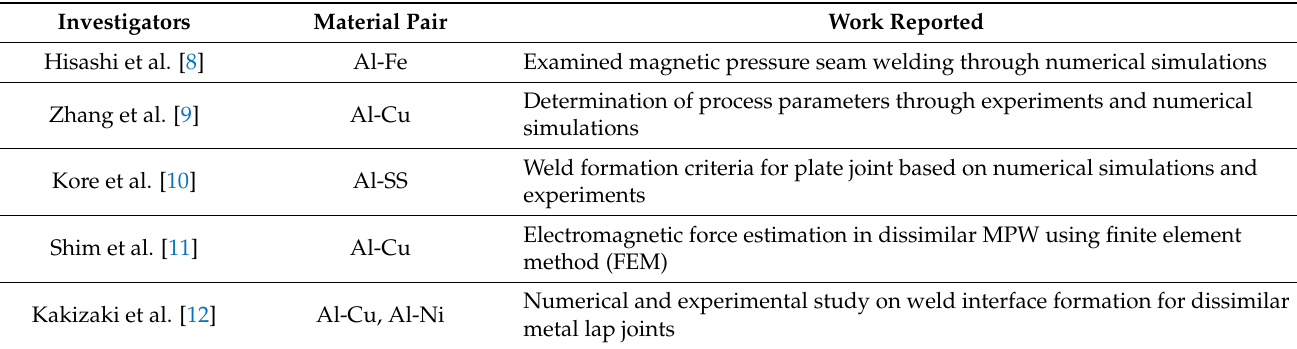
Table 1. Summary of available literature on numerical and experimental studies in MPW of dissimilar metal joints.